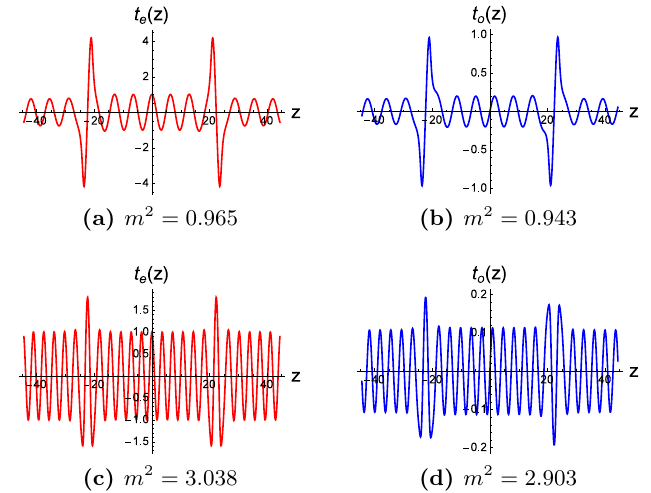
Figure 9. Plots of the even and odd parity resonance modes quasi-localized on the sub-branes for the double brane model (3.8). The parameters are set to k = 1, b = 7, and d = 2 :